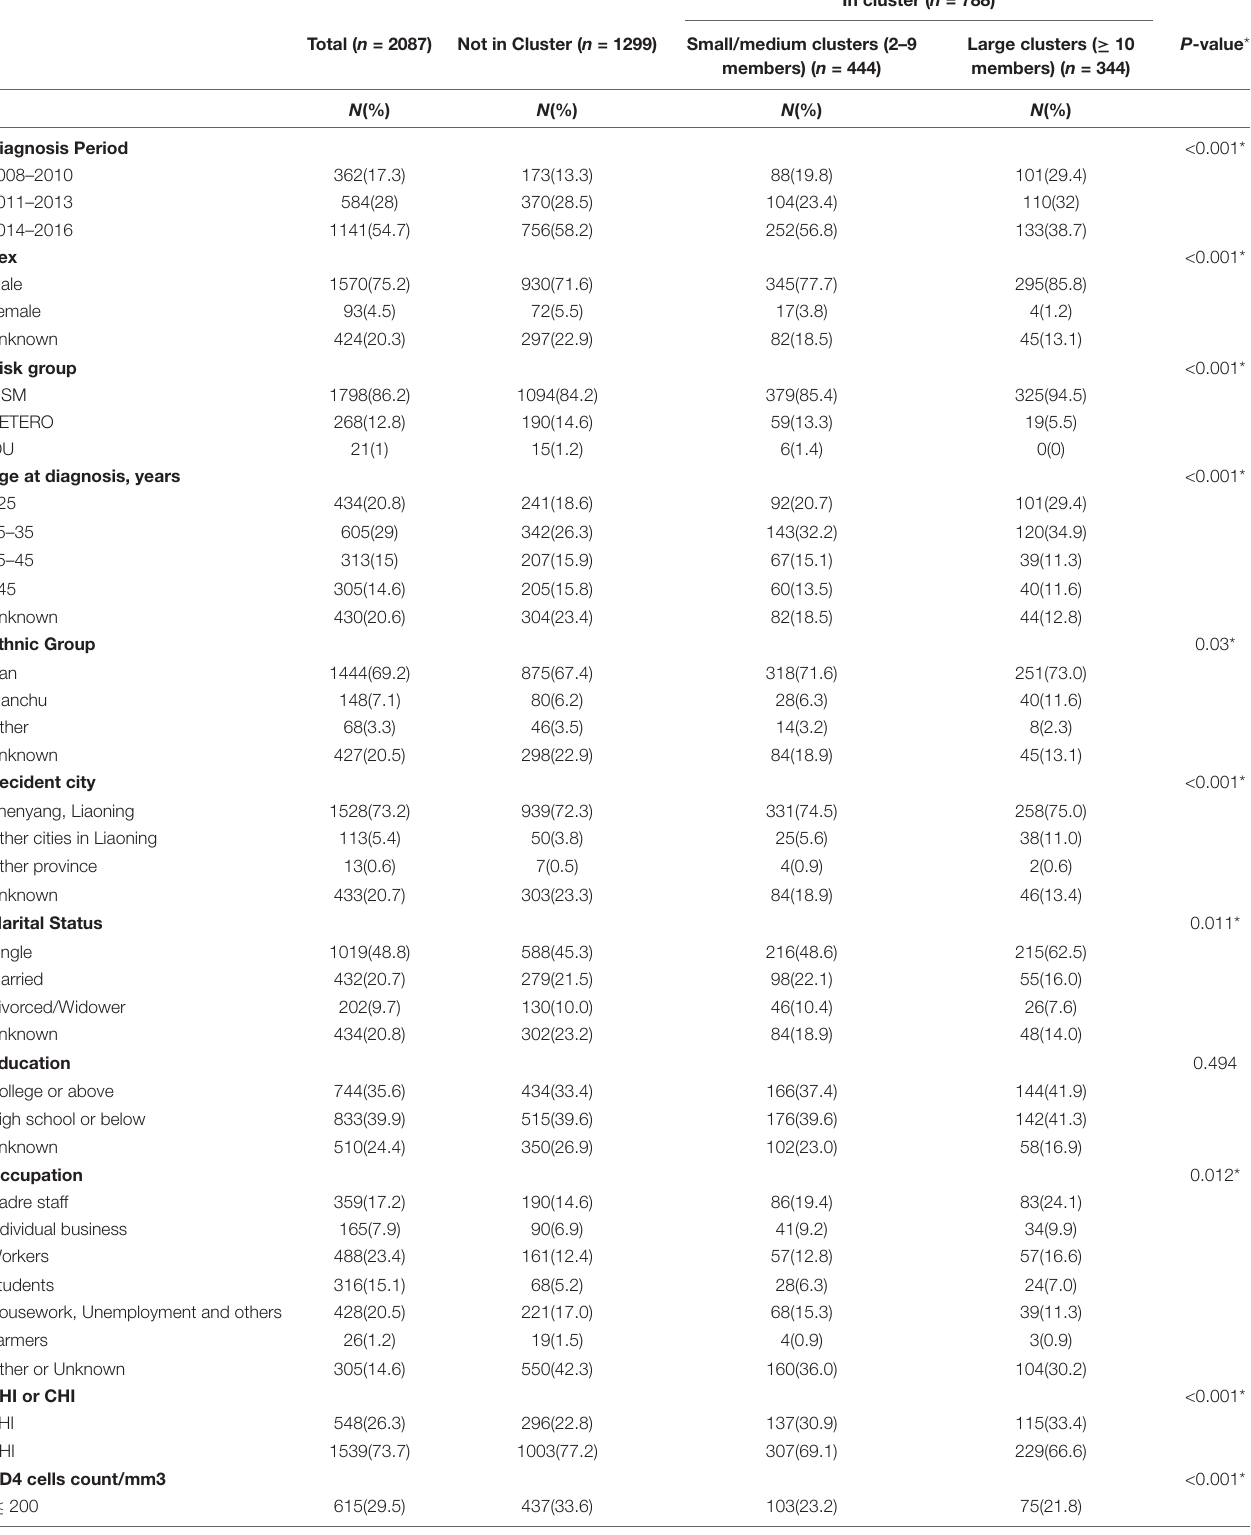
TABLE 1 | Comparison of characteristics of HIV-1 infected individuals by cluster inclusion and cluster